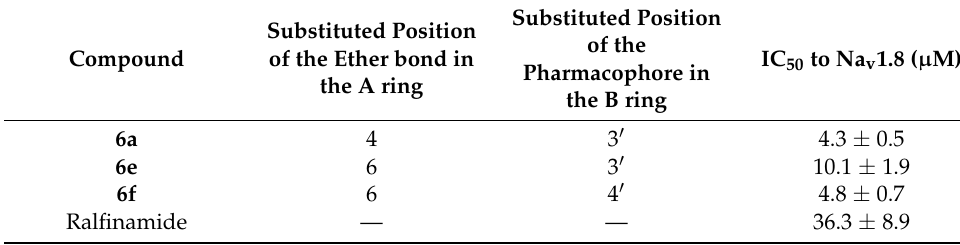
Table 5. Inhibitory activity of the compounds against Na v